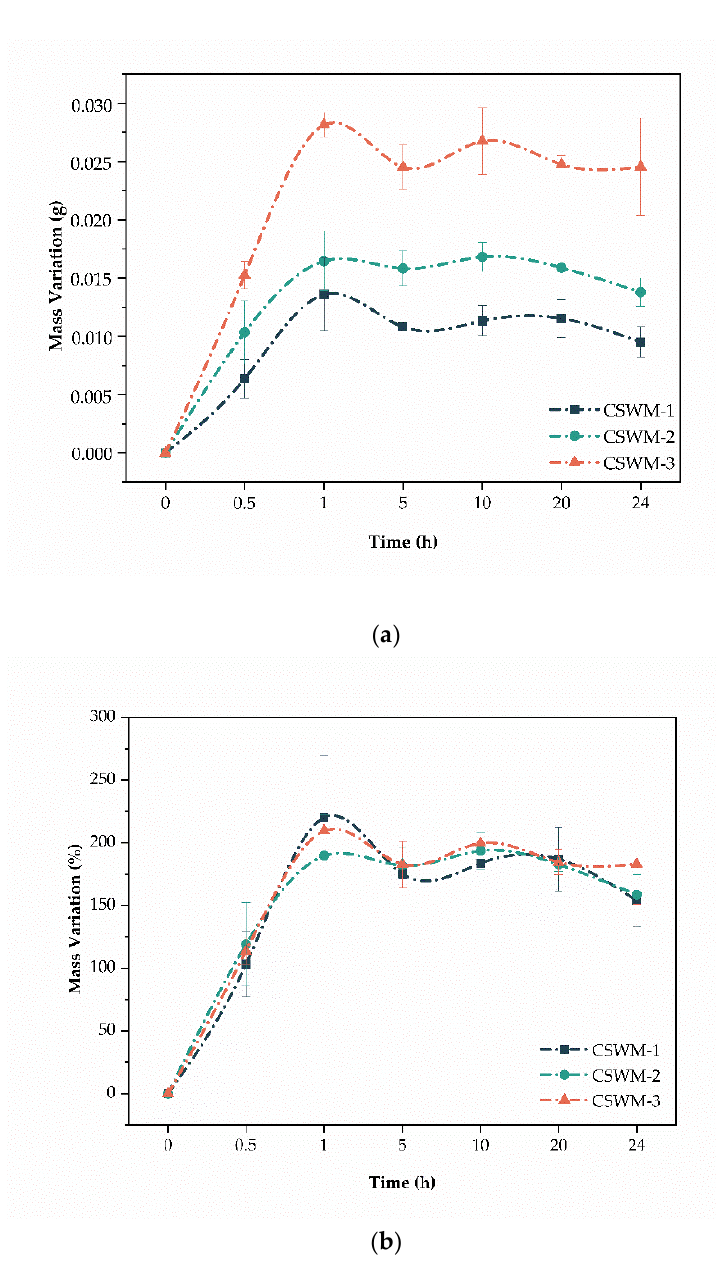
Figure 8. ( a ) Swelling behavior (absolute mass variation, in grams) of the chitosan woven meshes (mean ± standard deviation) and ( b ) swelling behavior (relative mass variation, in the percentage of the initial mass) of the chitosan woven meshes (mean ± standard deviation).